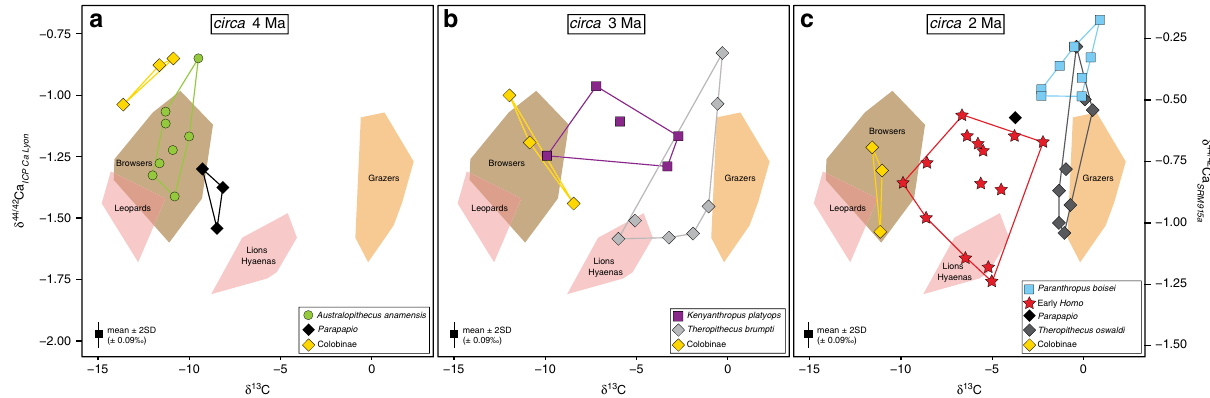
Fig. 2 δ 44/42 Ca (in ‰ ) as a function of δ 13 C (in ‰ ) measured from tooth enamel of fossil hominin and non-hominin primates from the Turkana Basin area, Kenya for different time bins, i.e., circa 4 Ma, circa 3 Ma and circa 2 Ma (numbers of biologically independent samples per group: n = 9 for Colobini; n = 4 for Parapapio sp.; n = 7 for Theropithecus brumpti ; n = 8 for Theropithecus oswaldi ; n = 8 for Australopithecus anamensis ; n = 5 for Kenyanthropus platyops ; n = 8 for Paranthropus boisei ; n = 13 for early Homo ). The colored areas represent the domains for previously analyzed extant terrestrial mammal enamel from the Turkana Basin area 29 ( n = 4 for leopards; n = 10 for lions and hyaenas; n = 24 for browsers; n = 18 for grazers). δ 44/ 42 Ca values are expressed both against ICP Ca Lyon (left) and SRM915a (right). The average 2SD of each Ca isotopic value is represented at the bottom left of each graph. Source data are provided as a Source Data fi